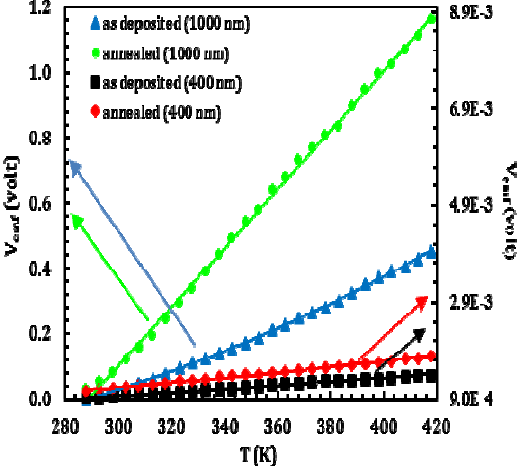
, S and ∆ W for as th emf